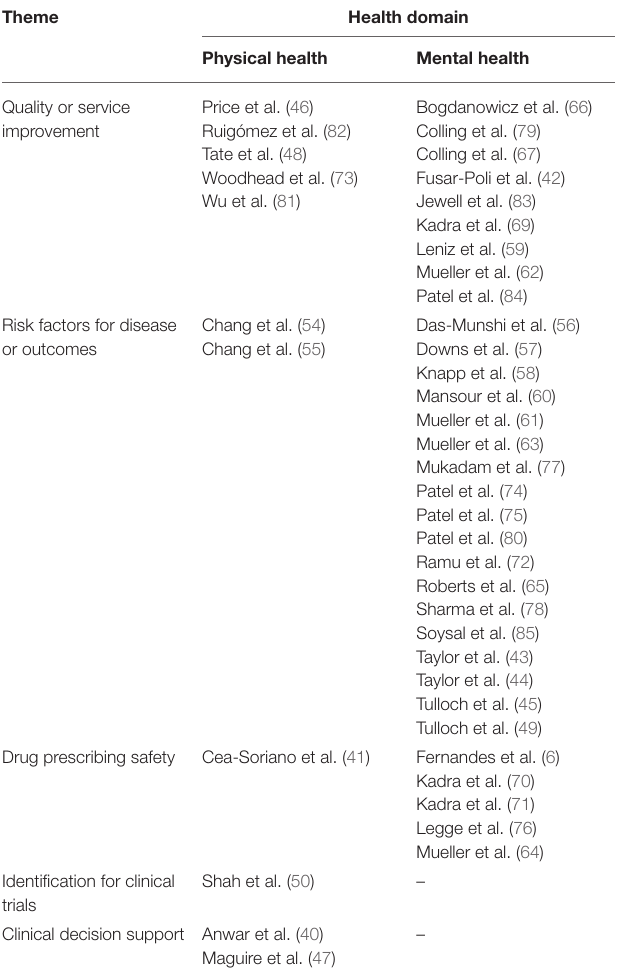
TABLE 1 | Contribution of each study to themes.